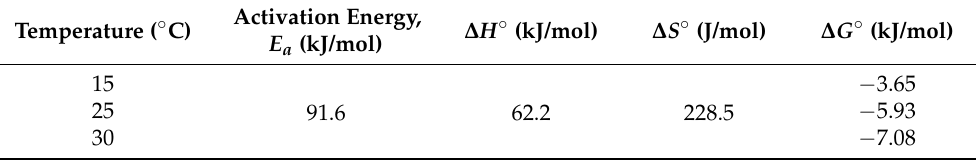
Table 4. Thermodynamic parameters of CPX adsorption on palm fiber